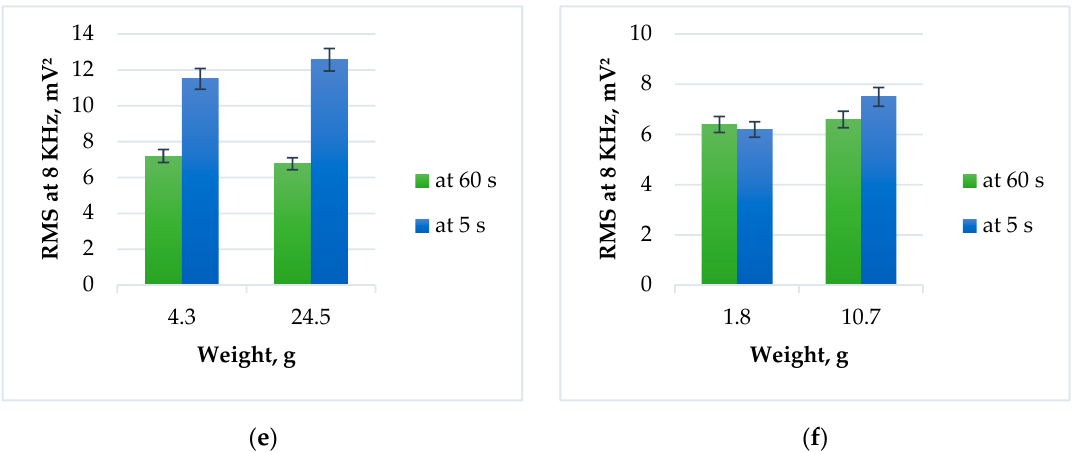
Figure 5. RMS of the recorded signal’s amplitude at 8 kHz for two types of materials at various operational voltage V 0 : ( a ) 12Kh18N10T (AISI 321) steel, V 0 = 55 V; ( b ) D16 (AA2024) alloy, V 0 = 55 V; ( c ) 12Kh18N10T (AISI 321) steel, V 0 = 60 V; ( d ) D16 (AA2024) alloy, V 0 = 60 V; ( e ) 12Kh18N10T (AISI 321) steel, V 0 = 65 V; ( f ) D16 (AA2024) alloy, V 0 = 65 V.